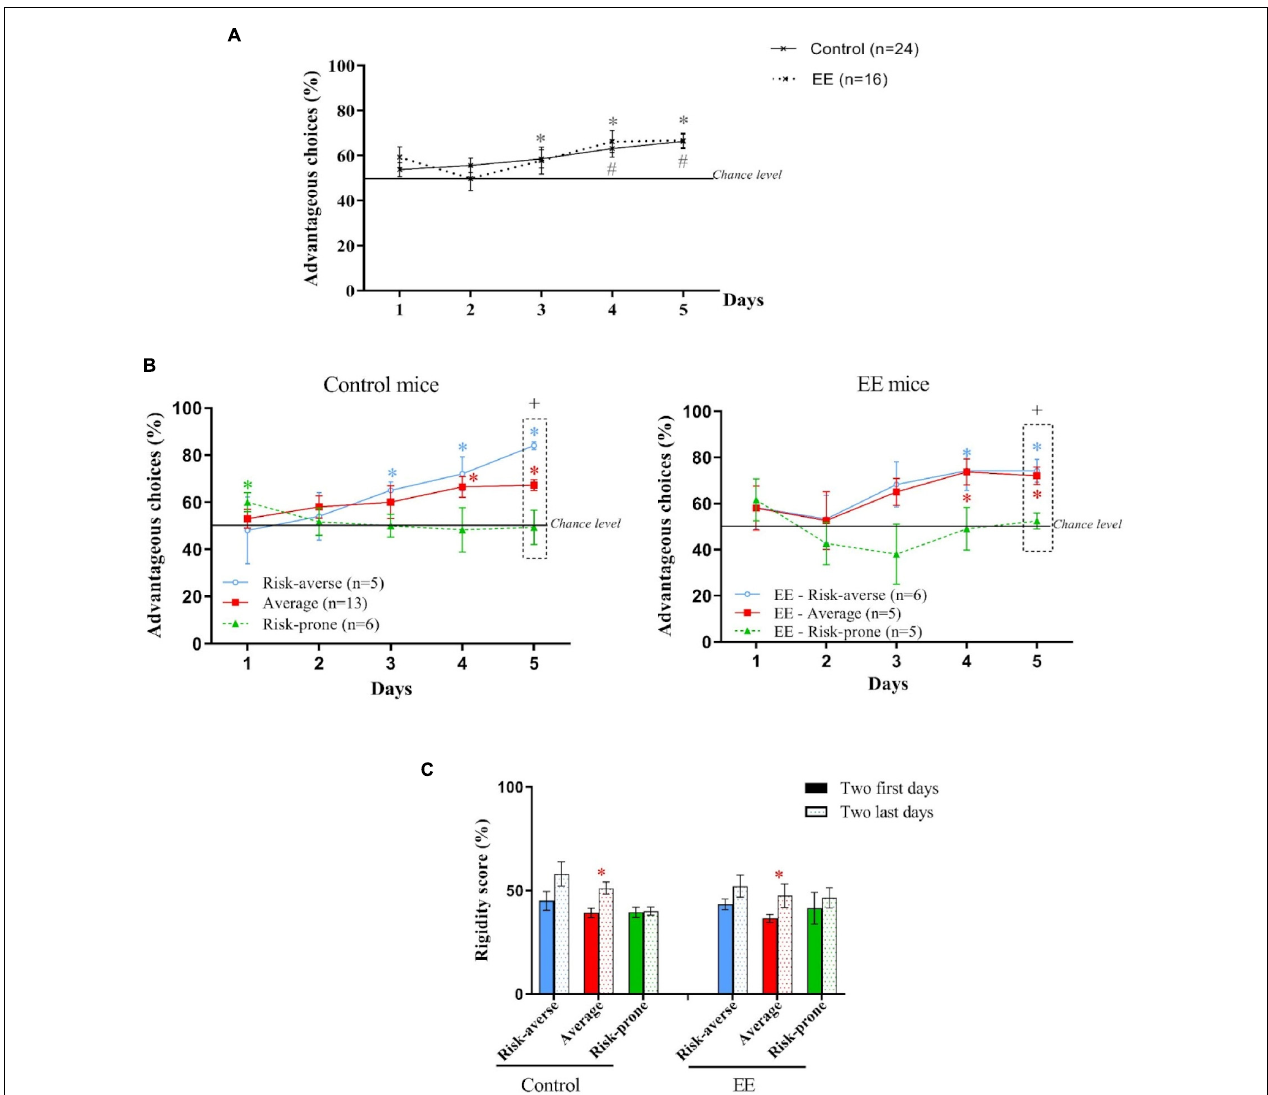
FIGURE 7 | (A) Evolution of preferences of animals as a group during the MGT for Control and EE mice. ∗ and # p < 0.05 from chance level. (B) Evolution of preferences of risk-averse, average and risk-prone mice from days 1 through 5 in the MGT for Control and EE mice. ∗ p < 0.05 from chance level. +, p < 0.05 differences from the three groups (Kruskal Wallis). (C) Rigidity scores of subgroups at the beginning and the end of the MGT for the control and EE mice. ∗ p < 0.05 difference between the first and last 2